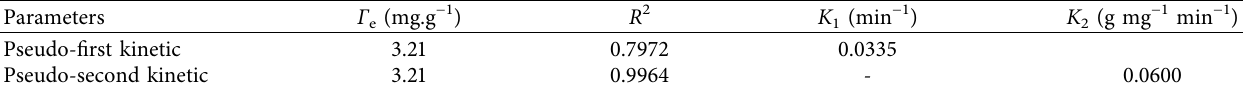
Figure 11: Kinetics of the PVBTAC adsorption isotherm on the α -Al conditions of C i , NCC of 10ppm, pH 8, NaCl 10 mM, and m α -Al2O3 of 3 mg mL − 1 . Table 2: Fitting parameters for the NCC adsorption onto the PVBTAC-modified α -Al pseudo-second kinetic.